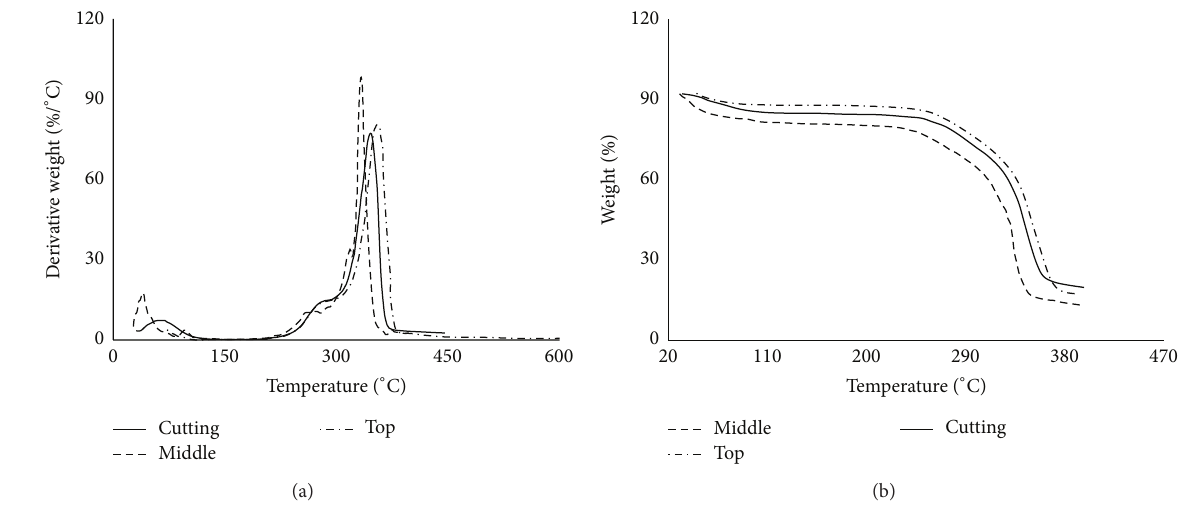
Figure 6: (a) DTGA and (b) TGA curves of different portions of raw jute fiber.